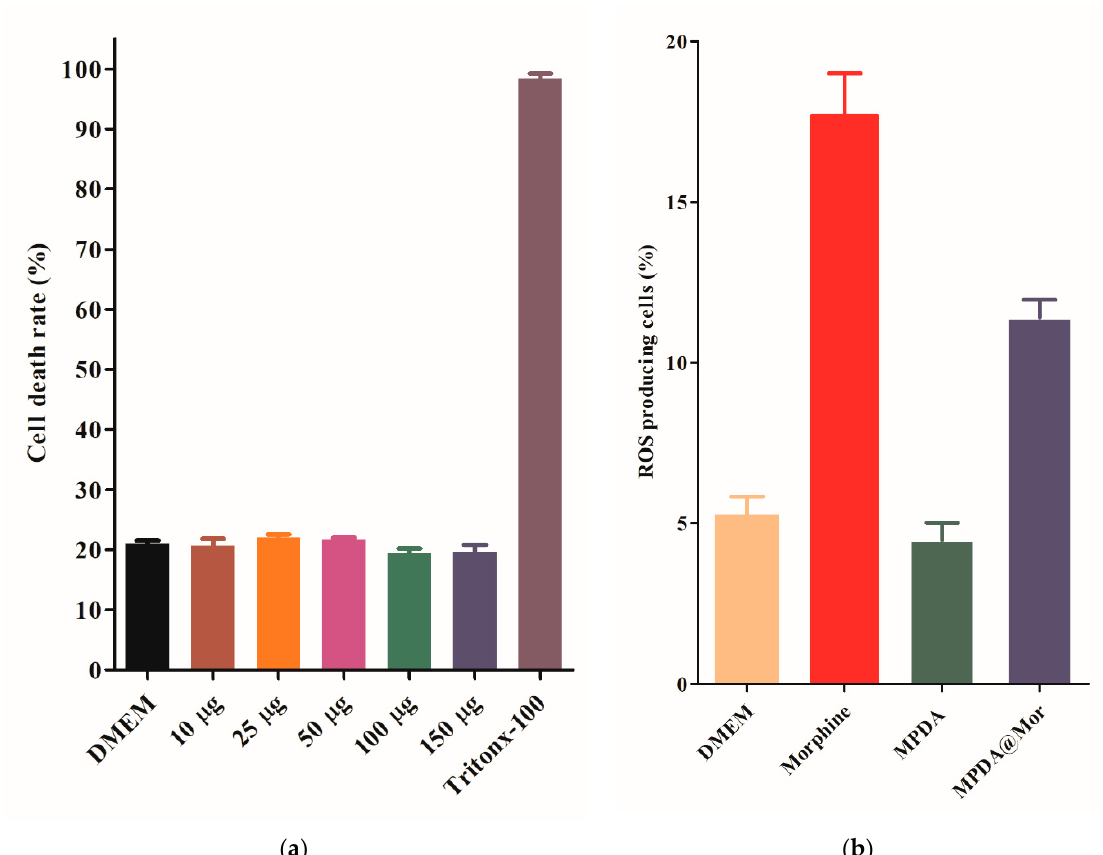
Figure 5. ( a ) Effect of MPDA on lactate dehydrogenase (LDH) leakage in CNS-1 neuronal cells. Cytotoxicity was determined by quantification of LDH release after 24 h of exposure to MPDA- nanoparticles (NPS) (10–150 μ g/mL). Data are means ± SD. Results were calculated as the percentage of the positive control (Triton X-100-lysed cells) (n = 3). ( b ) Determination of cellular reactive oxygen species (ROS) by DCFDA assay in THP cells.